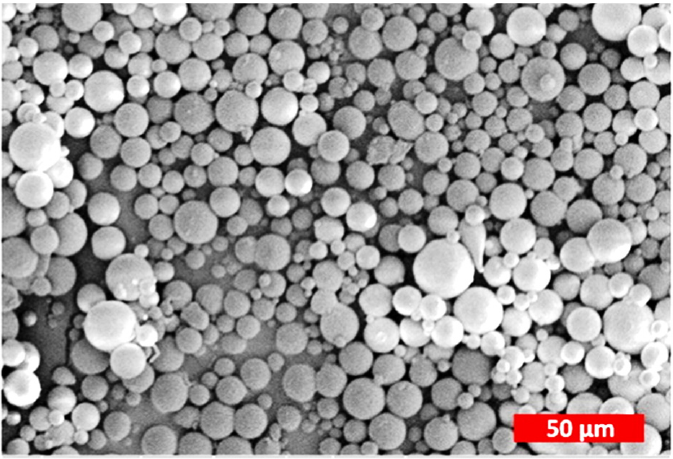
Figure 6. FESEM image of chitosan/zein nano-in-microparticles prepared by ionic gelation. Reprinted with permission from [137]. Copyright (2017) Elsevier.